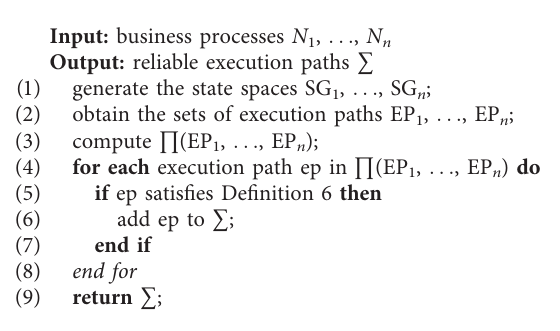
Algorithm 3 first generates the state space of each